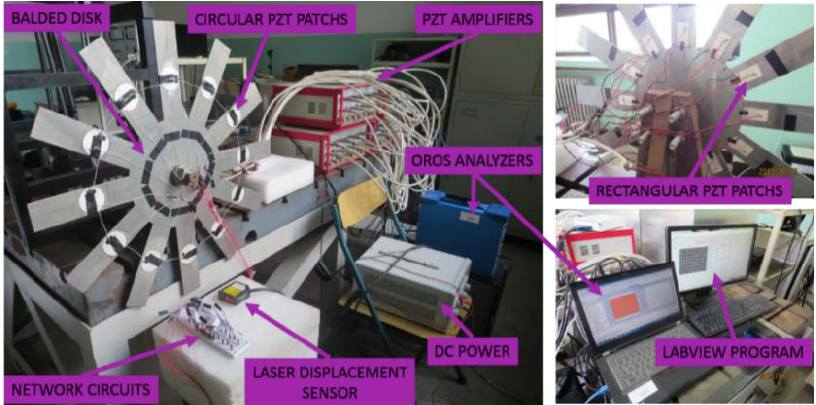
Figure 26. Experimental design for the vibration reduction of a bladed disk system excited by a traveling wave.